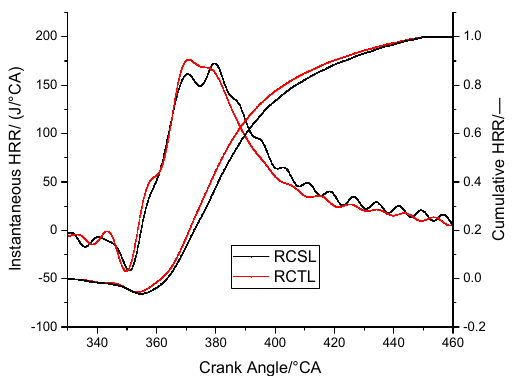
Figure 13. P max and exhaust temperature for two combustion chambers at BMEP2.6 MPa load.